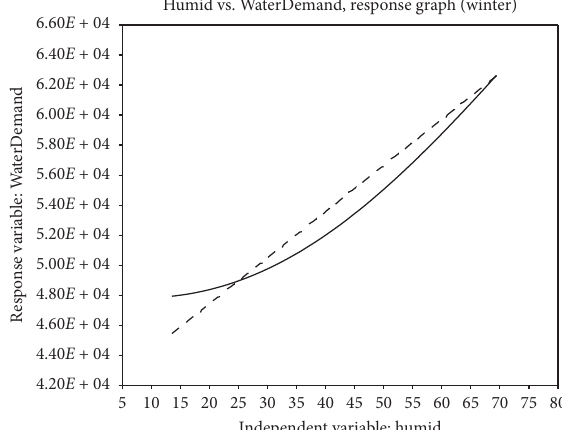
Figure 17: The reaction of water consumption to relative humidity with winter conditions by GLM and SVM-Nu